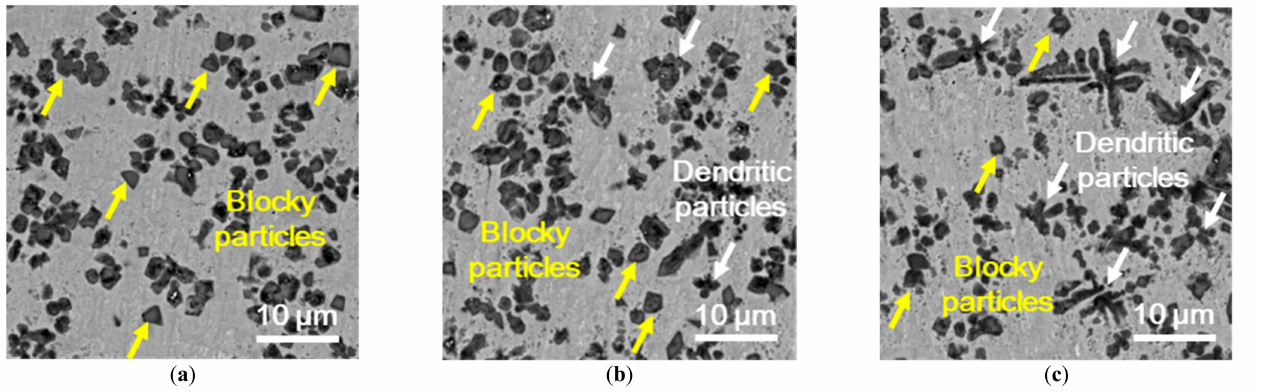
Figure 6. Microstructure of ( a ) EEMMC1.5-T, ( b ) EEMMC1.5-C, and ( c ) EEMMC1.5-B.